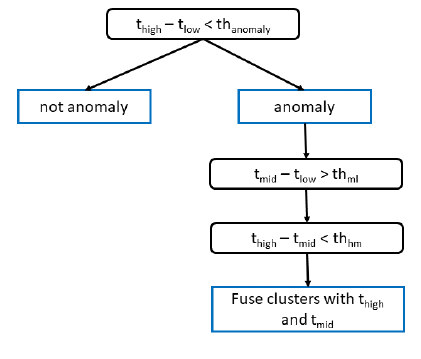
Figure 2 Anomaly decision tree